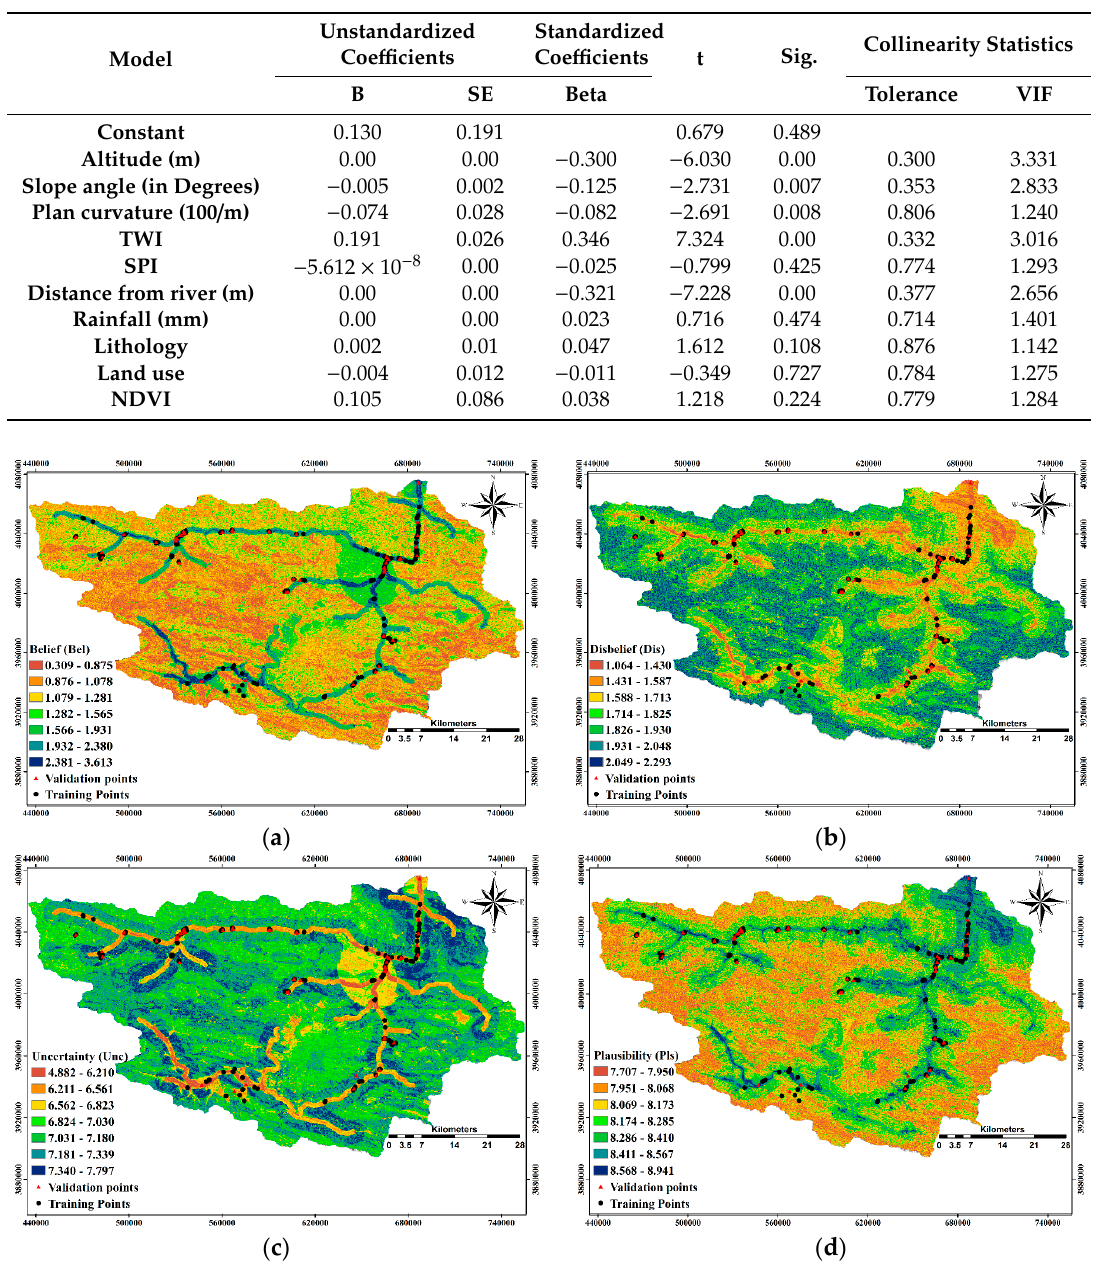
Figure 5. Integrated results of EBF model: ( a ) belief (Bel), ( b ) disbelief (Dis), ( c ) uncertainty (Unc), ( d ) plausibility (Pls).